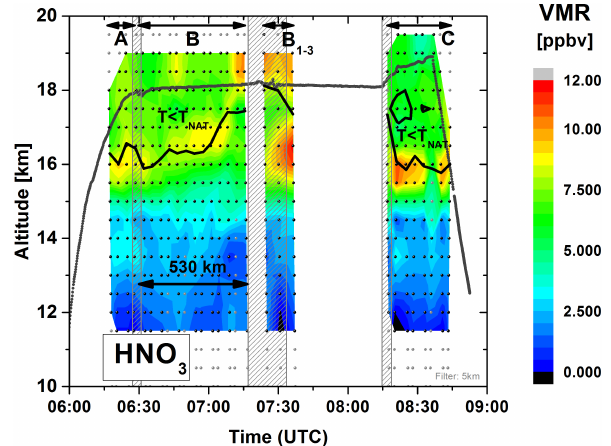
Figure 6. Vertical cross section of gas-phase HNO 3 retrieved from the MIPAS-STR observations associated with the flight on 25 Jan- uary 2010. Other parameters as in Fig. 4 (from Woiwode PhD thesis, 2013, with